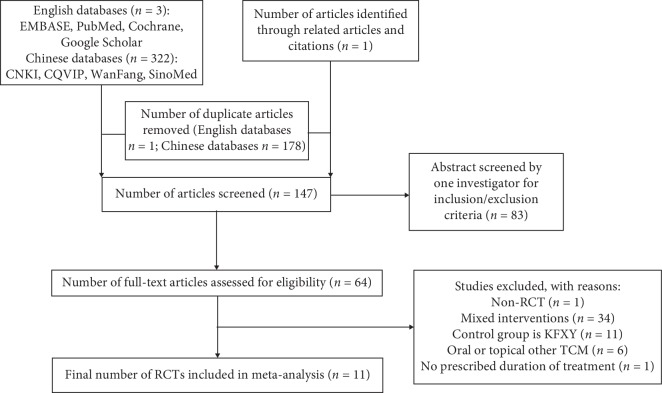
Summary of the literature identification and selection process.